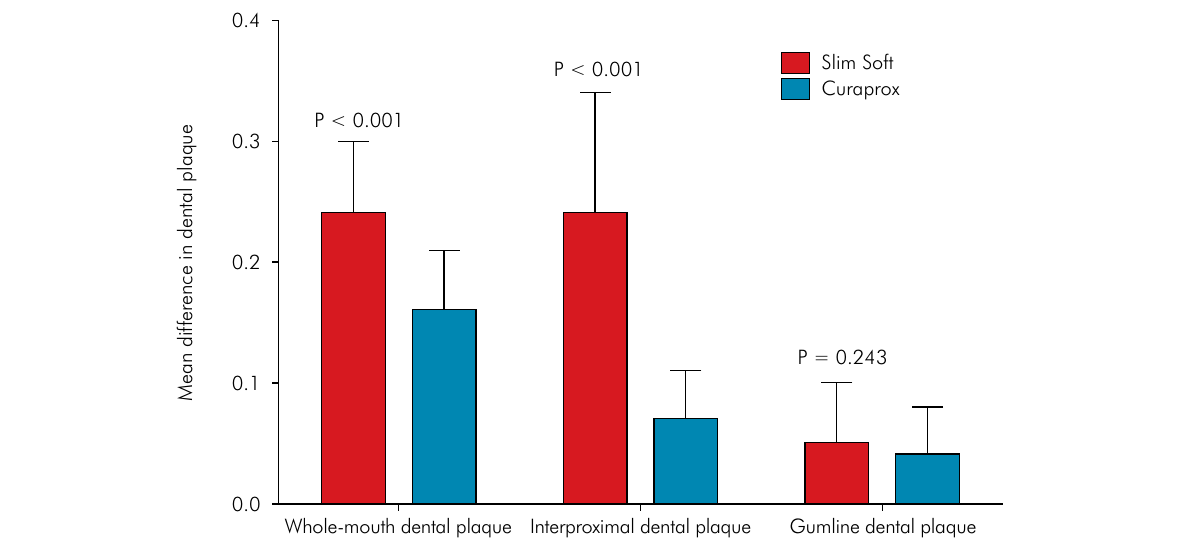
Figure 2. Mean differences in plaque scores from baseline pre-brushing to baseline post-brushing. p-values refer to inter-group comparisons (analysis of